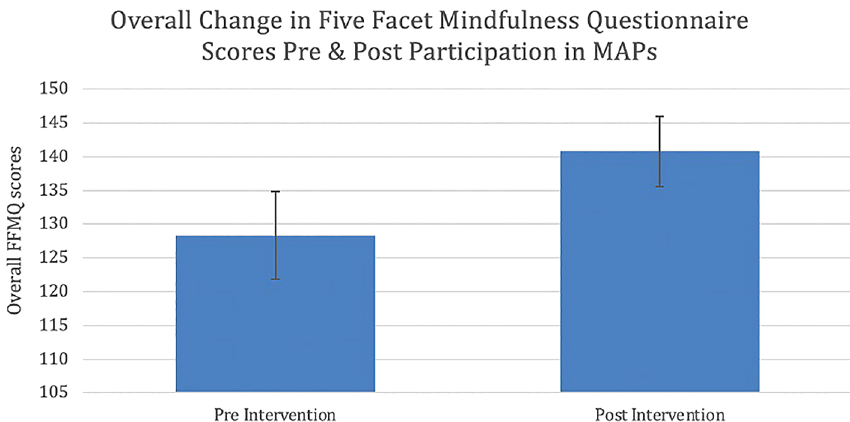
Figure1.MeanchangeinoverallFFMQscorespreandpostparticipationinMAPsprotocol(p=0.007). Errorbars represent standard errors (SEM). FFMQ: Five Facet Mindfulness Questionnaire. MAPs: Mindfulness Awareness